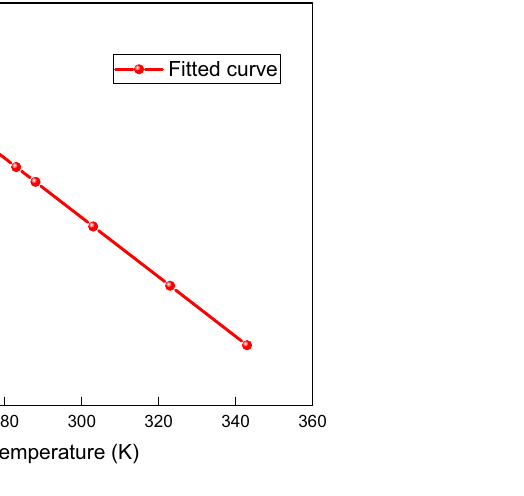
Figure 2. Density of RP5 versus